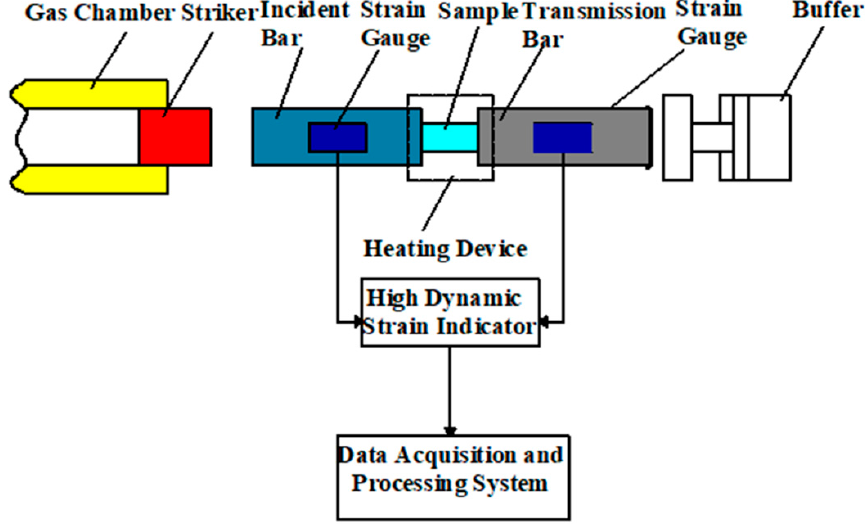
Figure 4. Principle diagram of Hopkinson compression bar experiment.